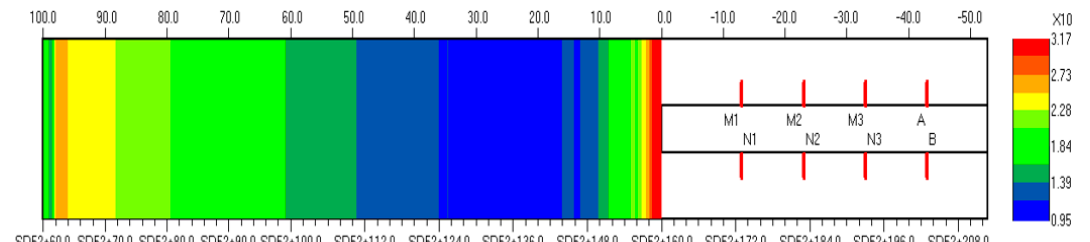
Figure 9. The advanced geological prediction result of the complex frequency conductivity method at SD52 + 160.